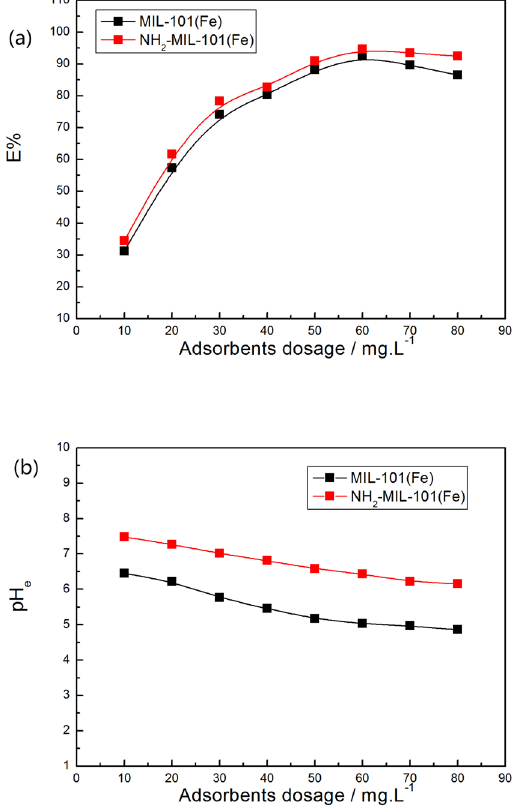
Figure 7. Effects of the adsorbent dosage on ( a ) the removal efficiency E% and ( b ) pH e on Fe-based MOFs (Adsorbents, 2–16 mg; NaH